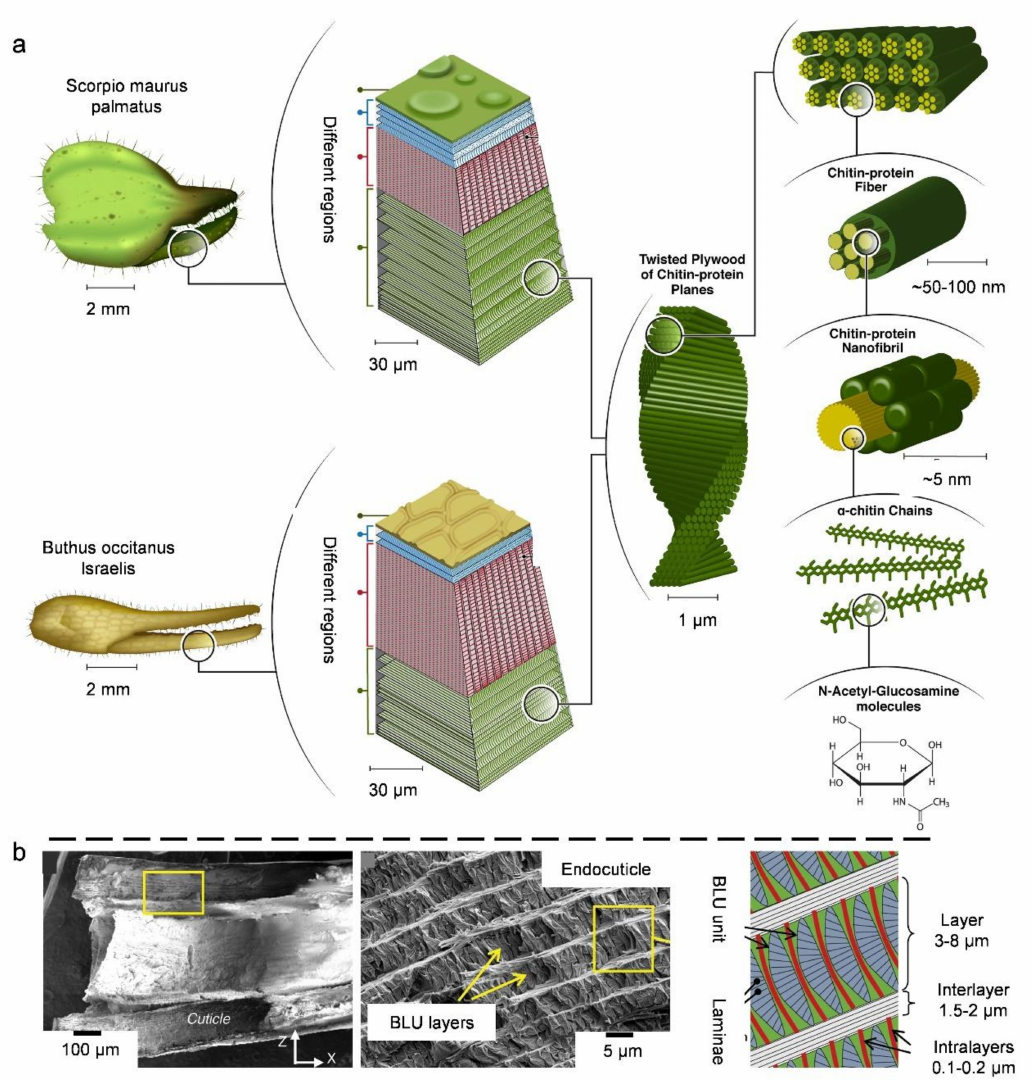
Figure 6. ( a ) Schematic illustration of the hierarchical structure in the Scorpio maurus palmatus and the Buthus occitanus israelis chela cuticle. Reprinted with permission from [94], copyright 2019 ELSEVIER SCI LTD. ( b ) Bouligand laminate unit geometrical model compare with their biological counterparts. Reprinted with permission from [95], copyright 2020 NATURE